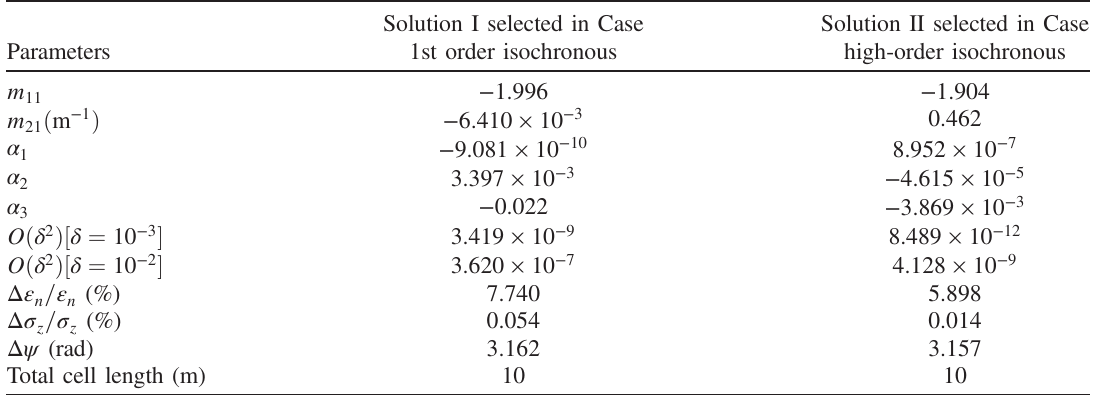
TABLE II. The relevant beam and lattice parameters of the two selected solutions.